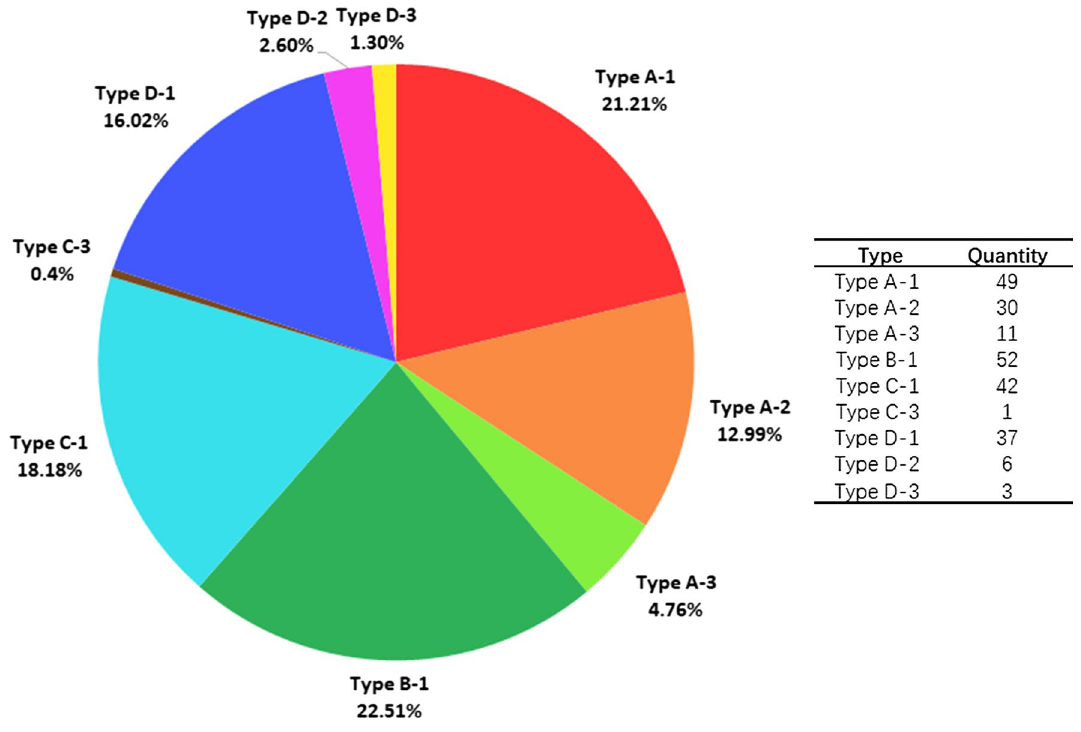
Fig. 7 Quantity and percentage of cities by